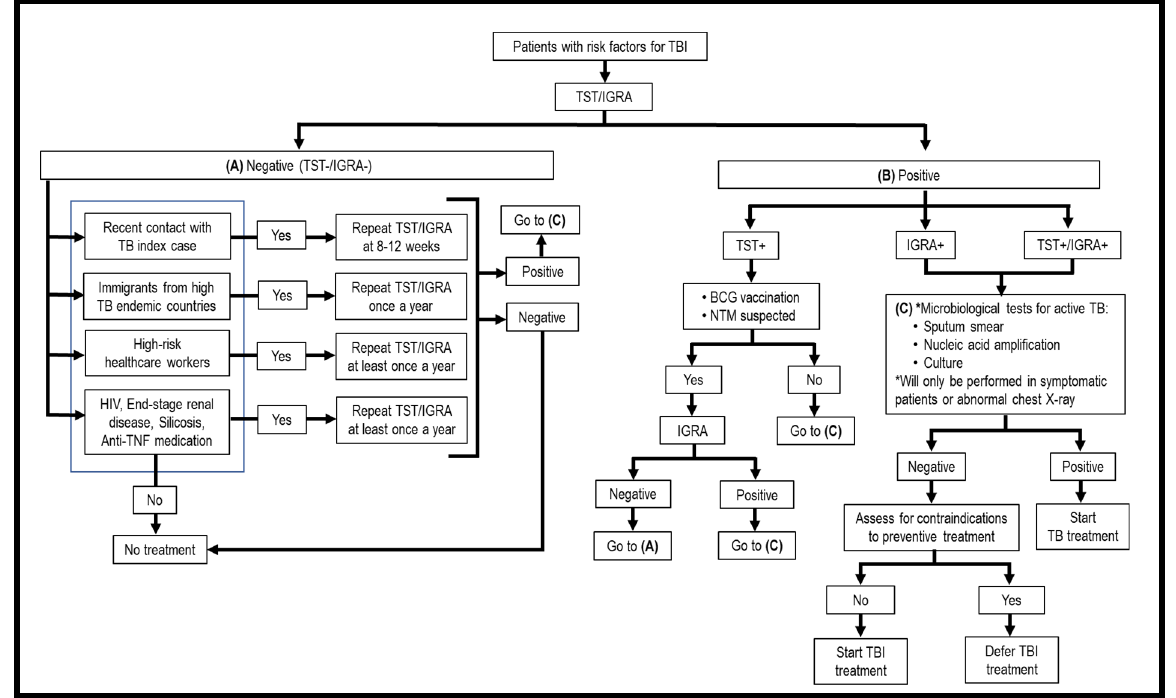
Figure 1. Flowchart of screening for TBI. Table 1. Diagnostic methods for TBI and ATB endorsed by WHO.